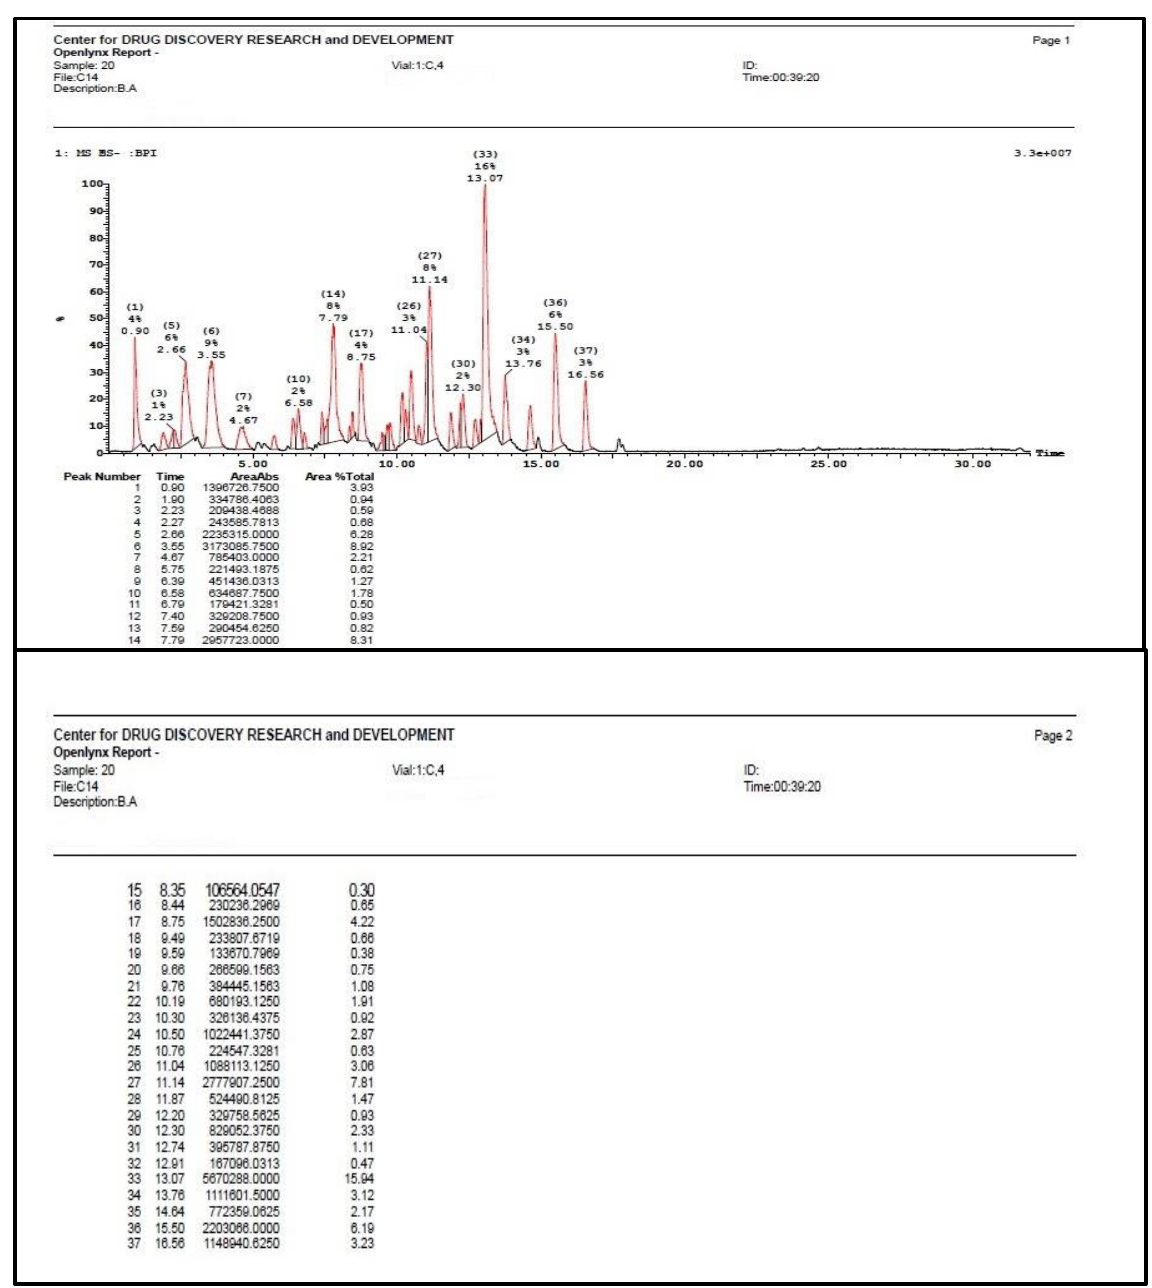
Figure12. UPLC chromatogram of B.A